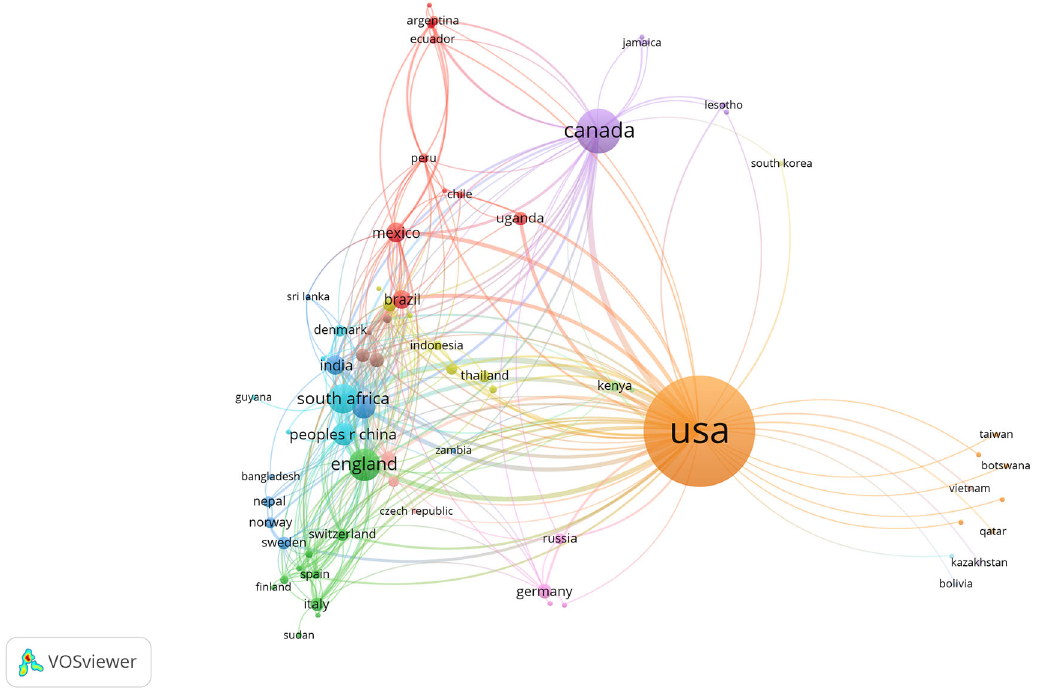
Figure 4. Country-level collaborations on syndemics-related